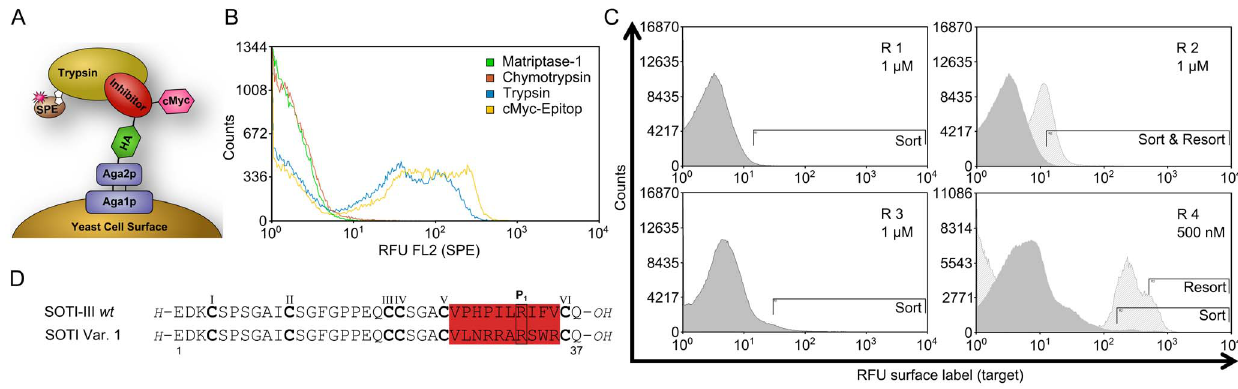
Figure 2. Yeast surface display of SOTI-III wildtype and screening against matriptase-1. ( A ) Schematic illustration of Aga1p/Aga2p surface-displayed inhibitor (red) flanked by the amino terminal HA (Human influenza hemagglutinin) epitope (green) and the carboxy terminal cMyc epitope (purple). Functional display of the inhibitor is monitored by incubation with biotinylated trypsin followed by fluorescence labeling with streptavidin, R-phycoreythrin conjugate (SPE). ( B ) FACS histogram overlay of yeast surface presented SOTI-III wild type labeled with anti-cMyc antibody (yellow), trypsin (blue), matriptase-1 (green) and chymotrypsin (brown). ( C ) FACS overlays of matriptase-1 binder enrichment. The sorting round (R) and the matriptase-1 concentration used in each round ( m M) is given in the figures. Dark grey: FACS histogram during sorting. Light grey: FACS histogram during resort (only rounds 2 and 4). ( D ) Sequence alignment of SOTI-III wild type and matriptase-1-binding SOTI variant 1. Randomized residues are colored in red. Cysteines are depicted in bold letters, while cystine connections are omitted for clarity.